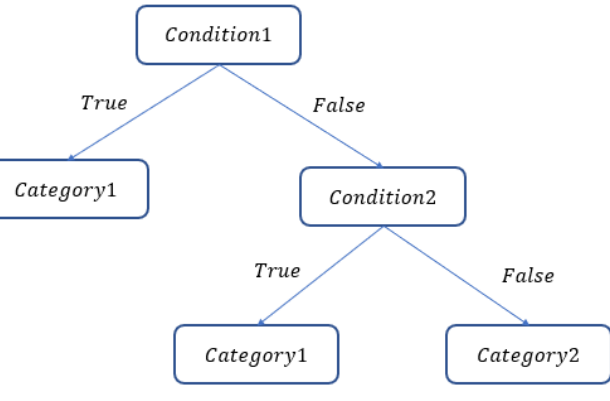
Figure 1. CART structure.